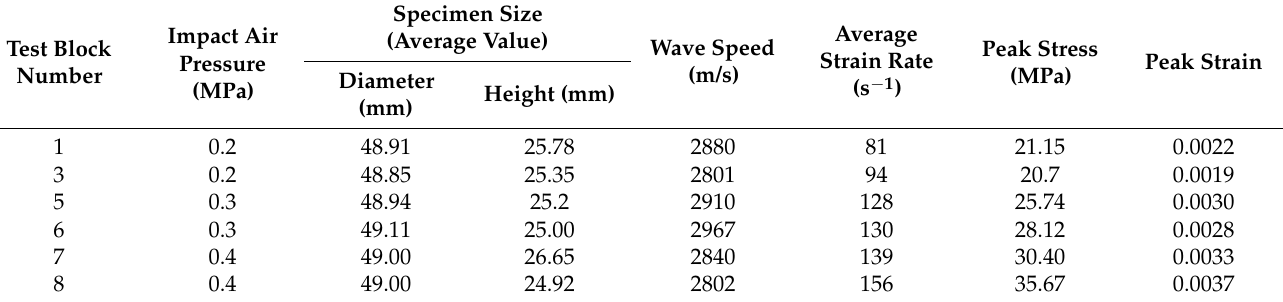
Figure 6. Stress–strain curves of mudstone-like samples. Table 3. Experimental data of mudstone-like materials.